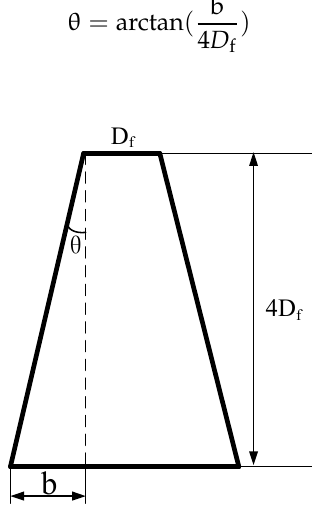
Figure 4. Definition of the spray half cone ‐ angle.